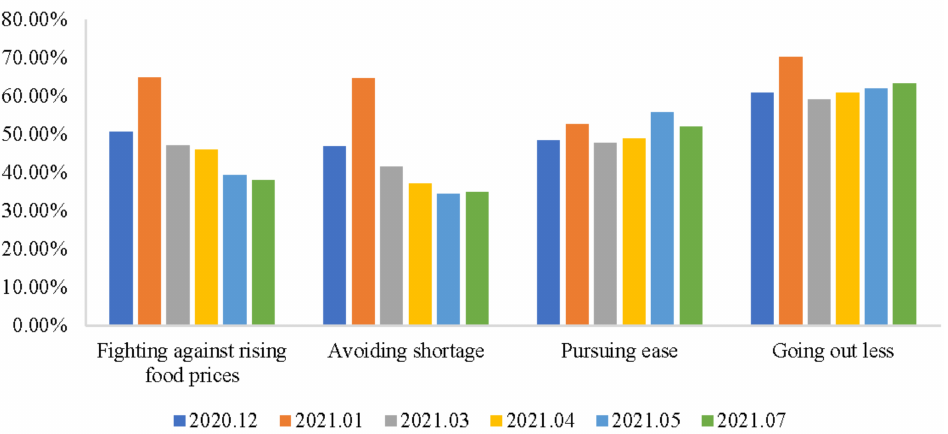
Figure 2. Motivations for food